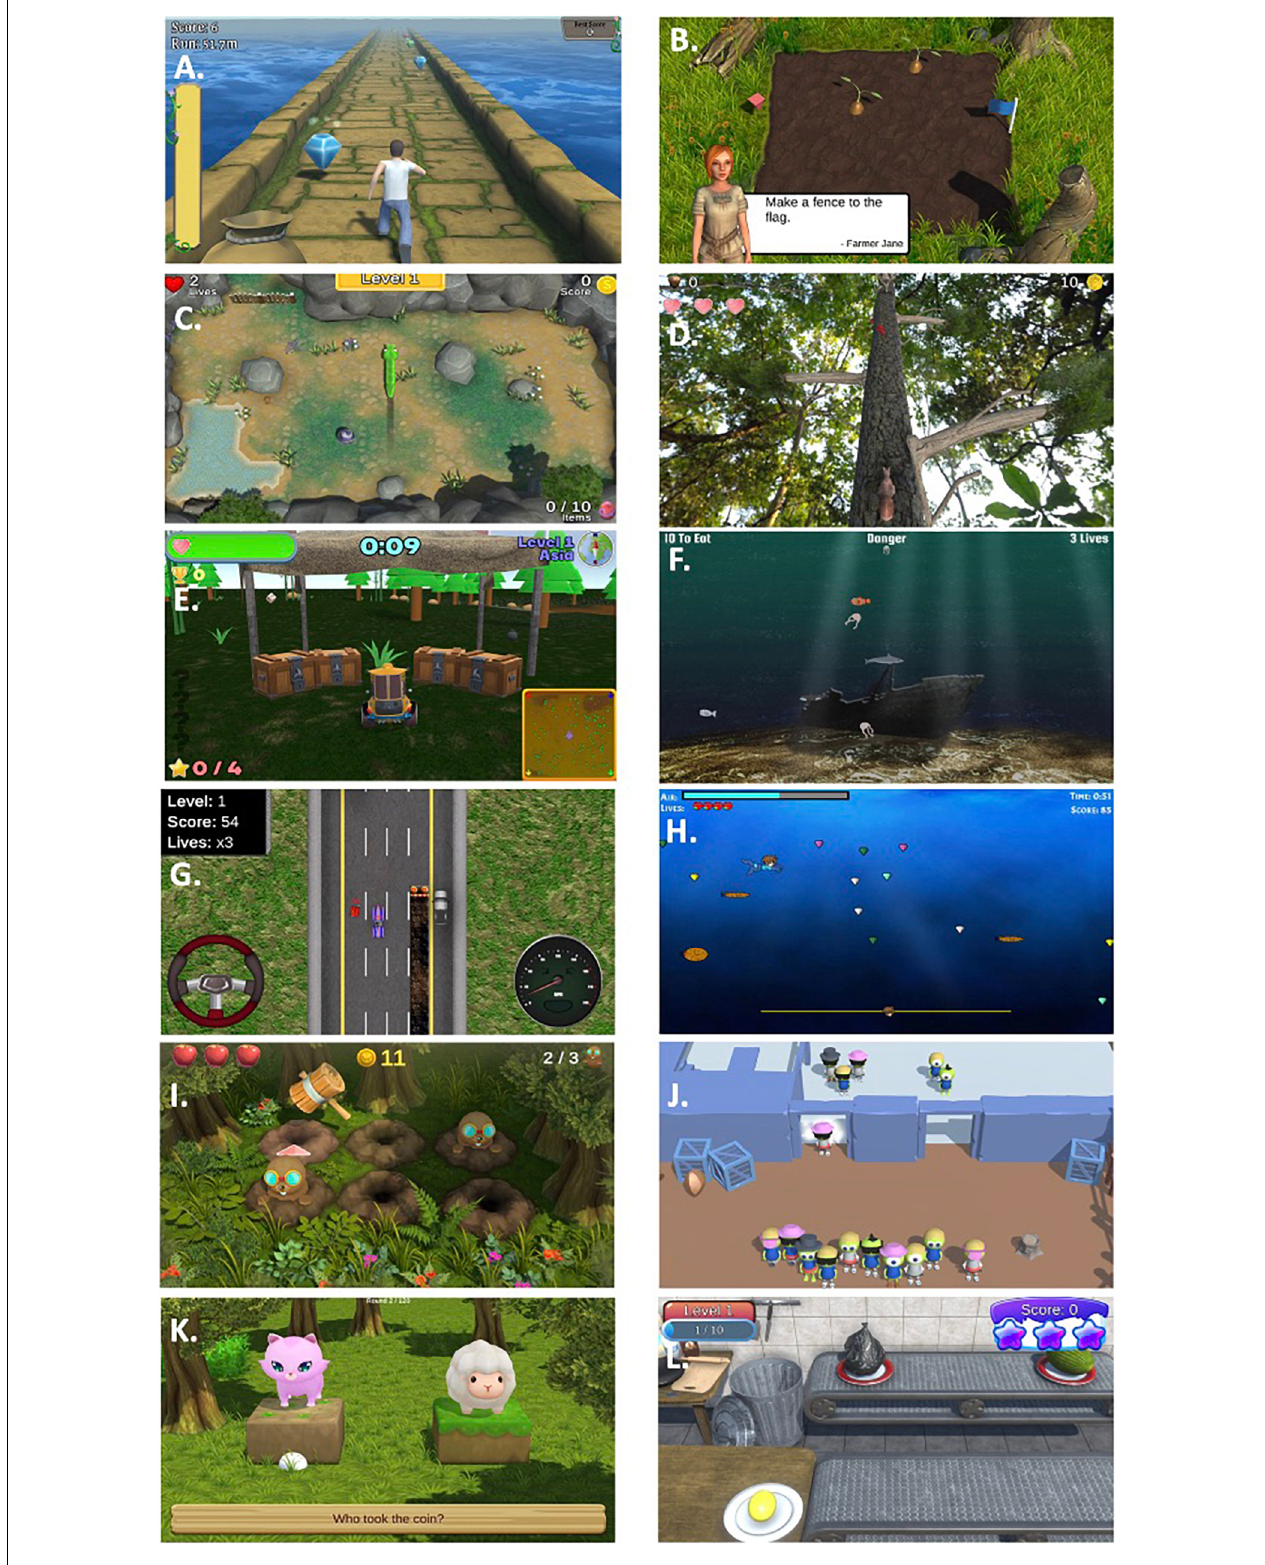
FIGURE 2 | Representative screenshots from each of the games included within the NeuroOrb suite: (A) A Bridge Too Far; (B) Farm Quest; (C) Snake; (D) Squirrel; (E) Sunday Driver; (F) Marine Life; (G) Driving Maniac; (H) Swimma; (I) Whack-a-Mole; (J) Munchkinis; (K) Who’s the Boss?; (L) Chow Time!